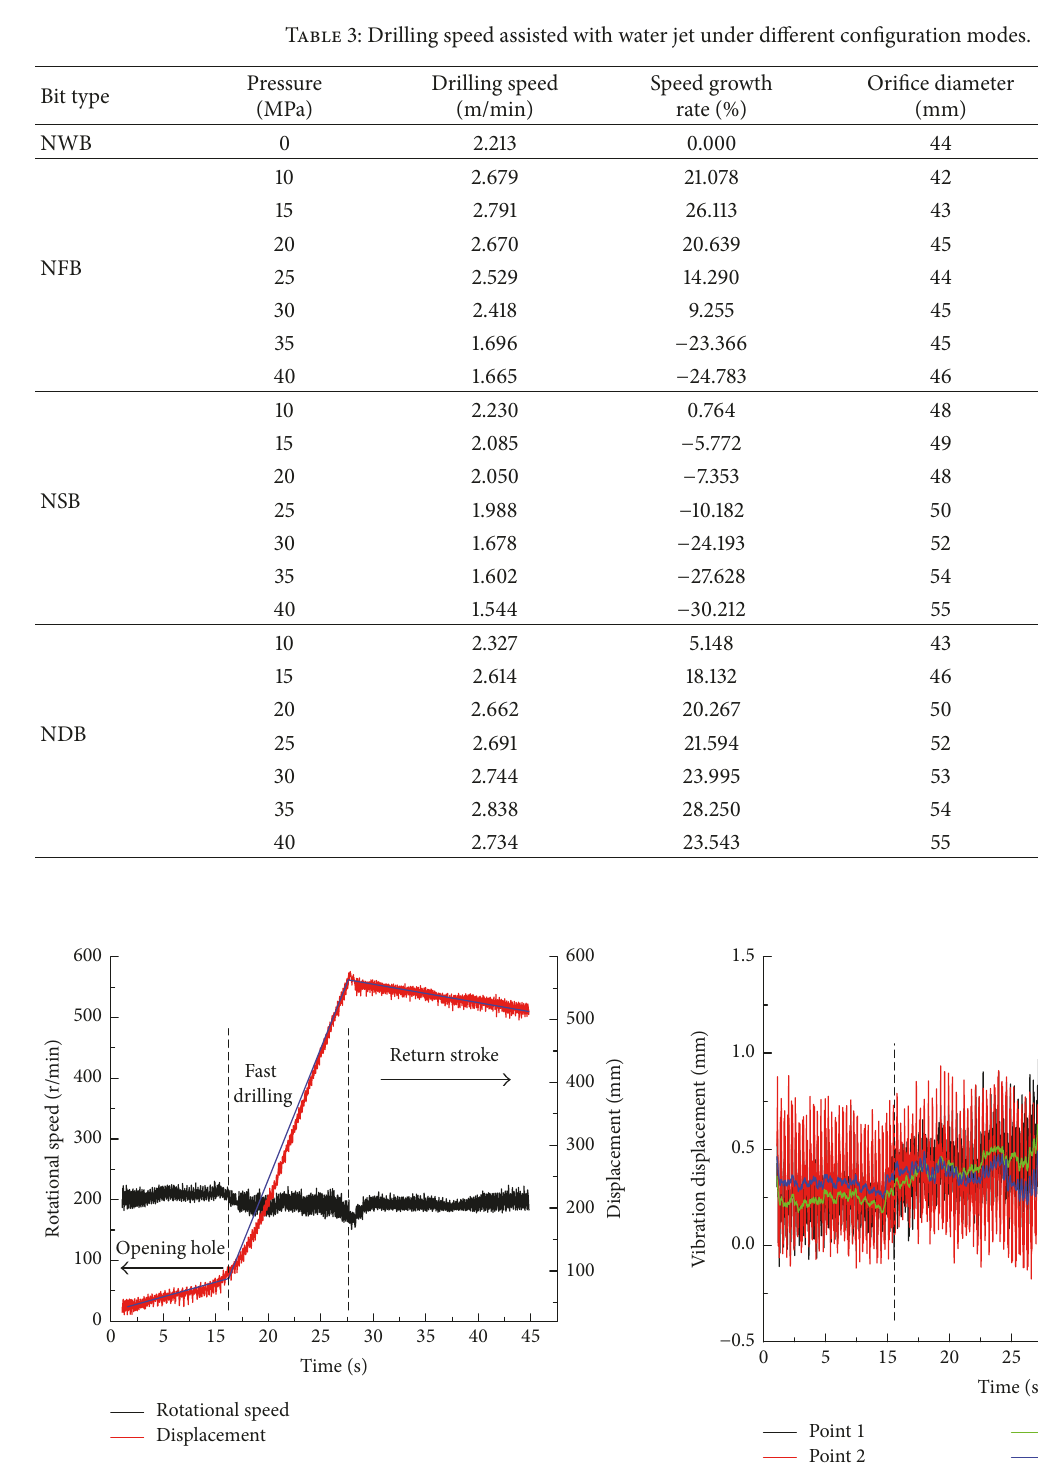
Figure 12: Rotational speed and displacement variation with time. surface. The drilling performance was enhanced when the water pressure increased. The side nozzle of NDB auxiliarily crushed concrete which enlarged the hole size and the space for debris removal and reduced the debris accumulation at the junction between the bottom and wall to ensure